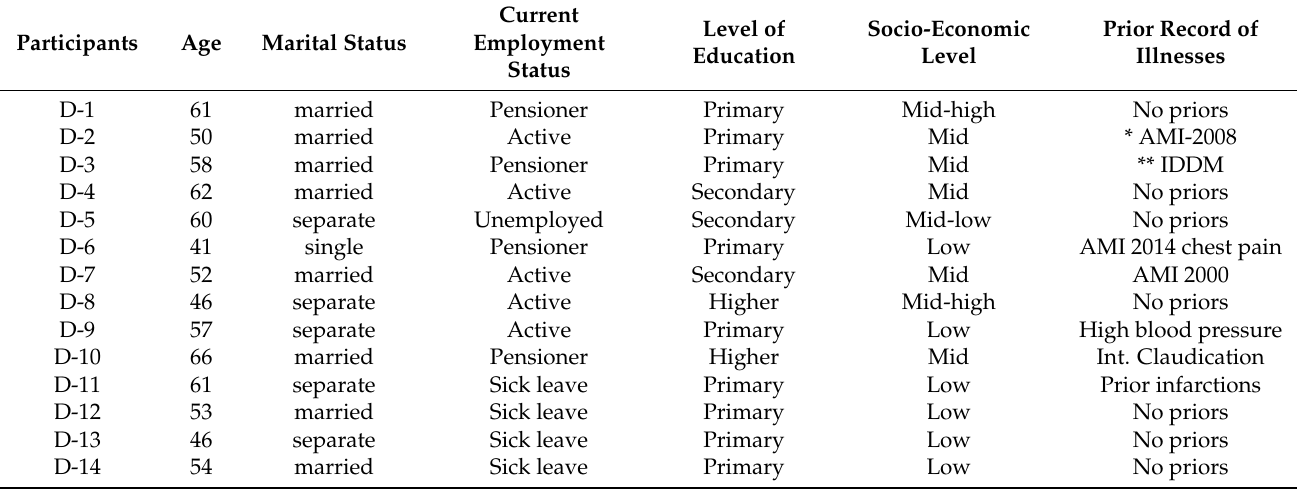
Table 2. Sociodemographic description of